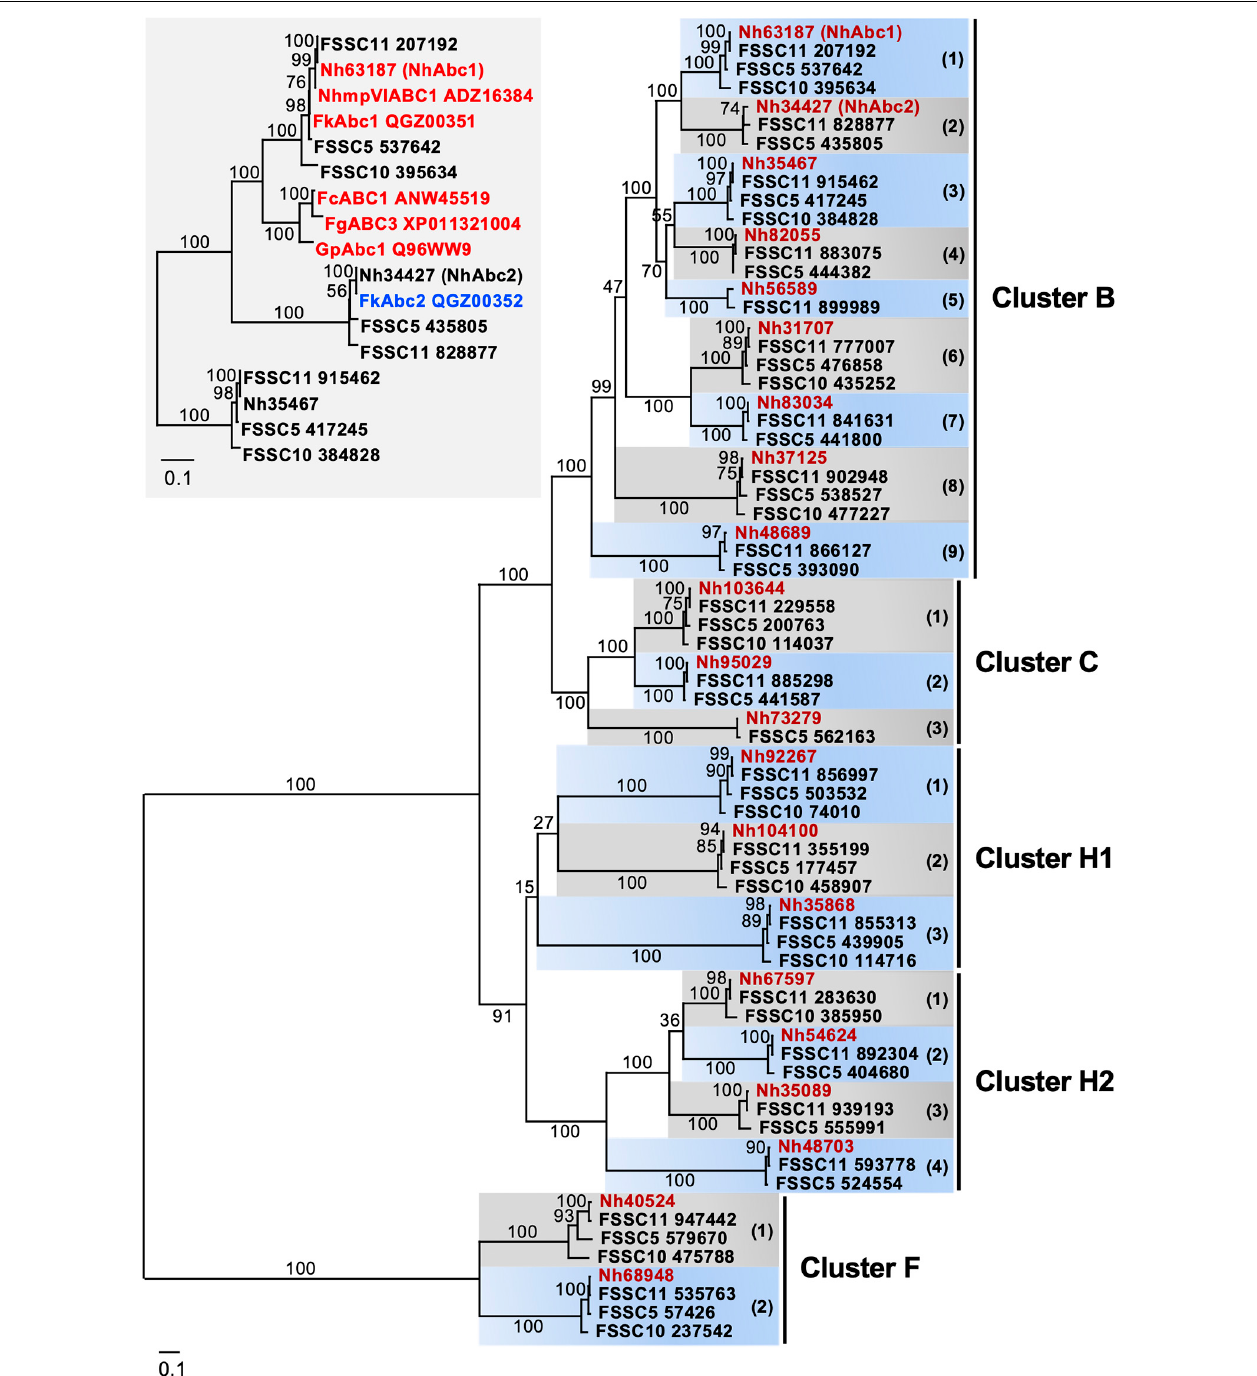
FIGURE 2 | Maximum likelihood phylogram of the entire repertoire of full-size PDR transporters of four FSSC species (i.e., FSSC5, FSSC10, FSSC11, N. haematococca ). The PDR transporters belong to four (B, C, F, H1, H2) of the eight major clusters (A-H) of fungal PDR transporters (Lamping et al., 2010). The 21 PDR transporters of Nectria haematococca (Nh) are highlighted in red. Numbers in brackets on alternating grey or blue background denote nine distinct cluster B, three cluster C, three cluster H1, four cluster H2 and two cluster F lineages, each showing 100% bootstrap support. Nh Abc1 and Nh Abc2, cluster B lineages 1 and 2, respectively, are shown in brackets. The percentage bootstrap support of 1,000 replicates is shown for all major branches. Inset: The phylogenetic relationship of Nh Abc1 and Nh Abc2 orthologues of the FSSC with those of related Fusarium species that have been shown to be involved in azole antifungal and/or phytoalexin resistance (red). F. keratoplasticum (i.e., FSSC2) Abc1 (red) and Abc2 (blue) were also included. Lineage 3 cluster B PDR transporters of the FSSC were used as the outgroup. The percentage bootstrap support of 1,000 replicates is shown for all branches. The scale bars indicate the number of amino acid substitutions per